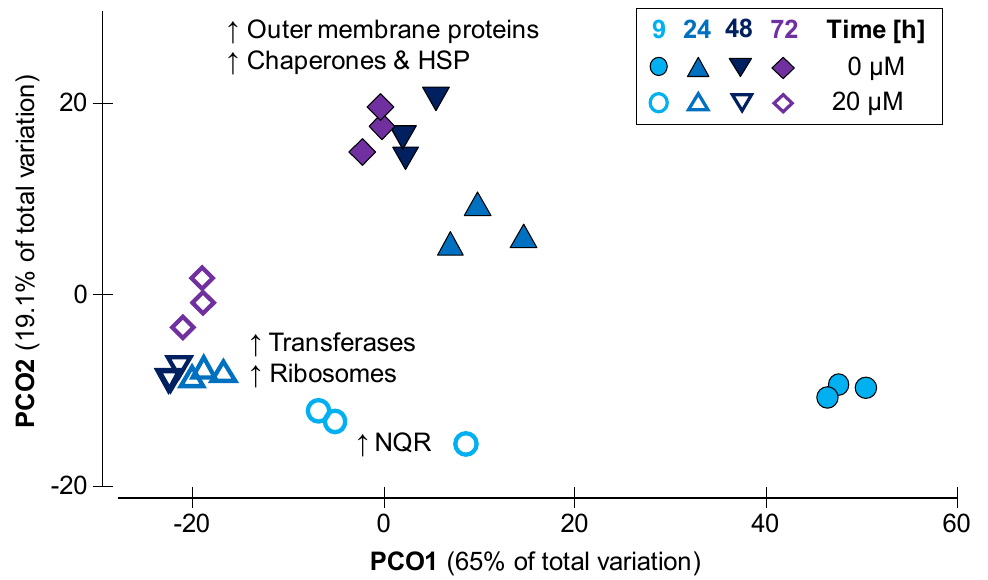
Figure 6. Changes of P. bryantii proteomes at 0 and 20 µM monensin after 9, 24, 48 and 72 h of incubation (n = 3 per time point and treatment). Data underwent a standardization by total, followed by resemblance matrix formation via Bray Curtis similarity.